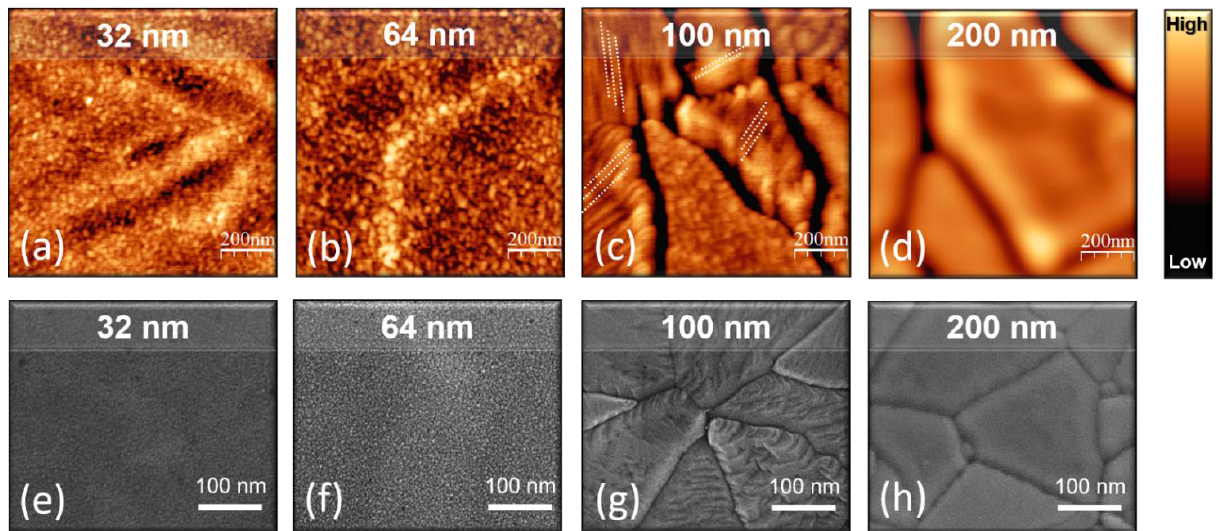
Figure 7. Tapping mode AFM topography, 1 µ m × 1 µ m in size, of ( a ) 32, ( b ) 64, ( c ) 100, and ( d ) 200 nm samples annealed at 800 °C. The color scale ranges from: 0 to 5 nm for the 32 and 64 nm samples; 0 to 20 nm for the 100, and the 200 nm samples. SEM images of ( e ) 32, ( f ) 64, ( g ) 100, and ( h ) 200 nm samples, annealed at 800 °C.